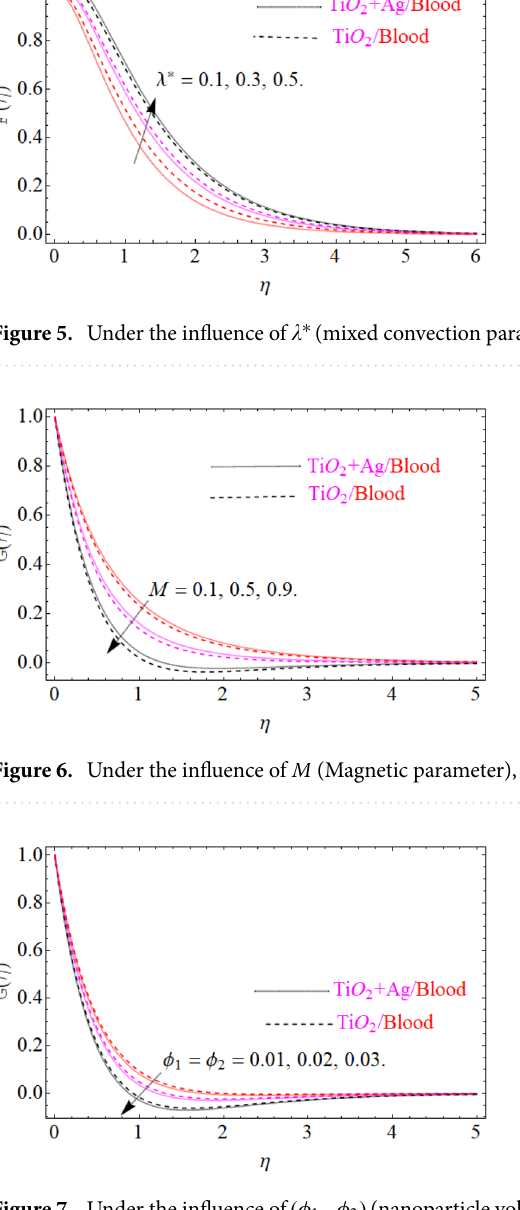
Figure 7. Under the influence of (φ 1 , φ 2 ) (nanoparticle volume friction), G (η)